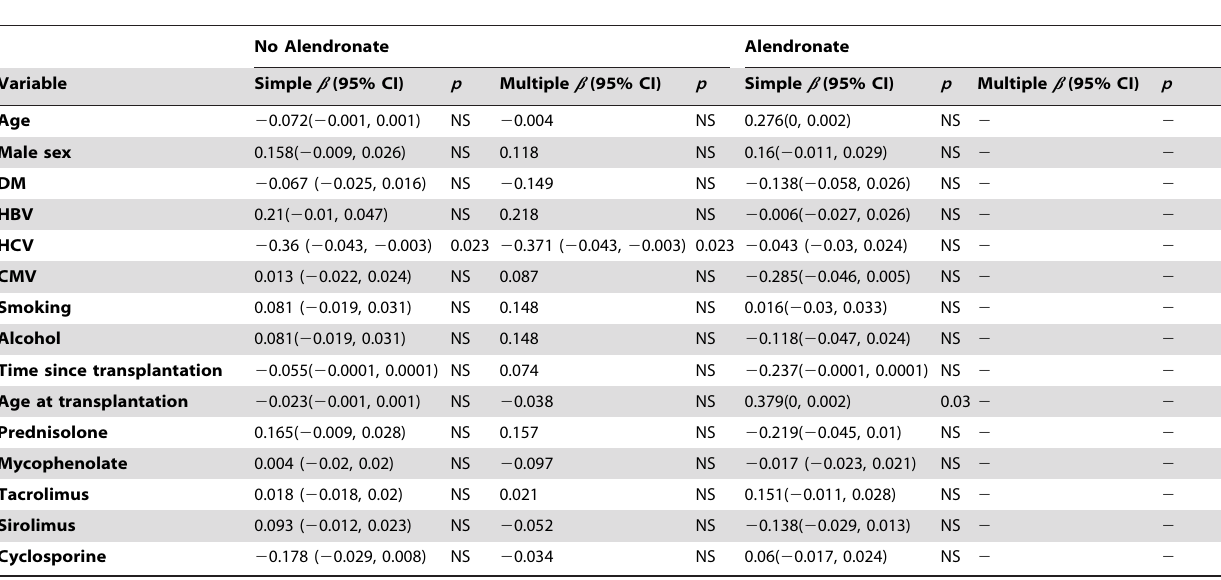
Table 5. Clinical variables associated with bone mineral density change of the lumbar spine in patients taking (n=34) and not taking (n=42) alendronate